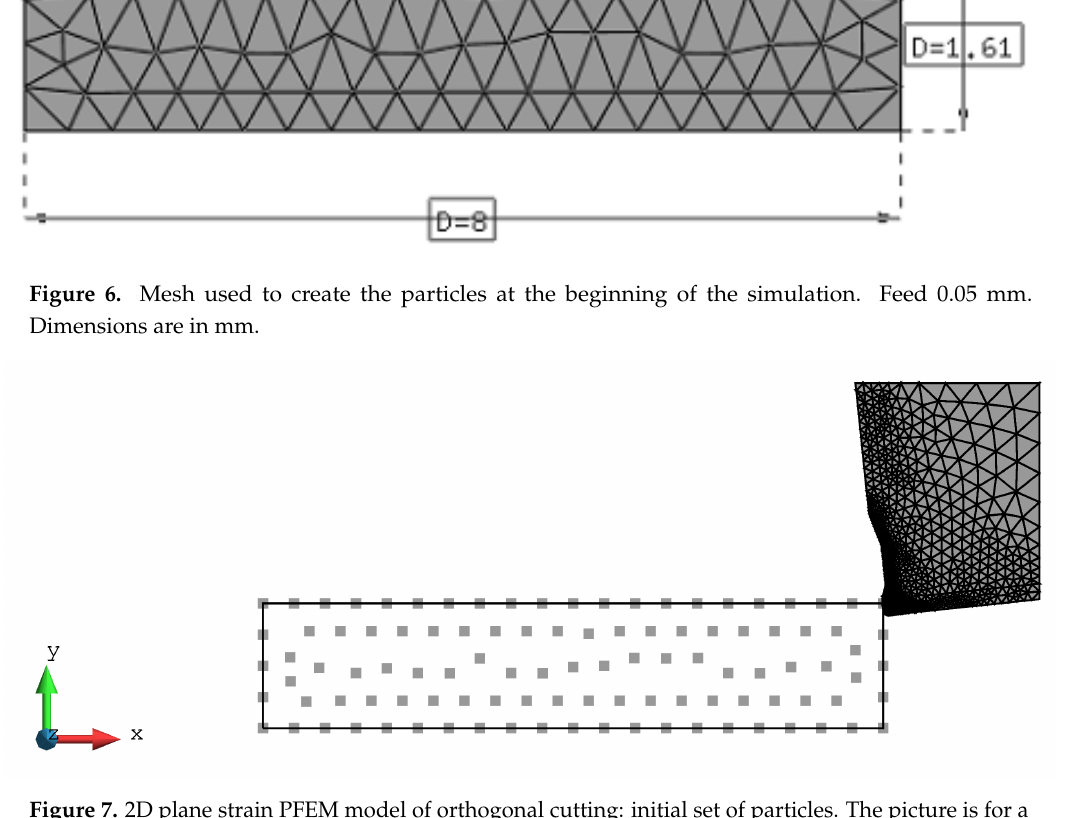
Figure 7. 2D plane strain PFEM model of orthogonal cutting: initial set of particles. The picture is for a feed of 0.05 mm.